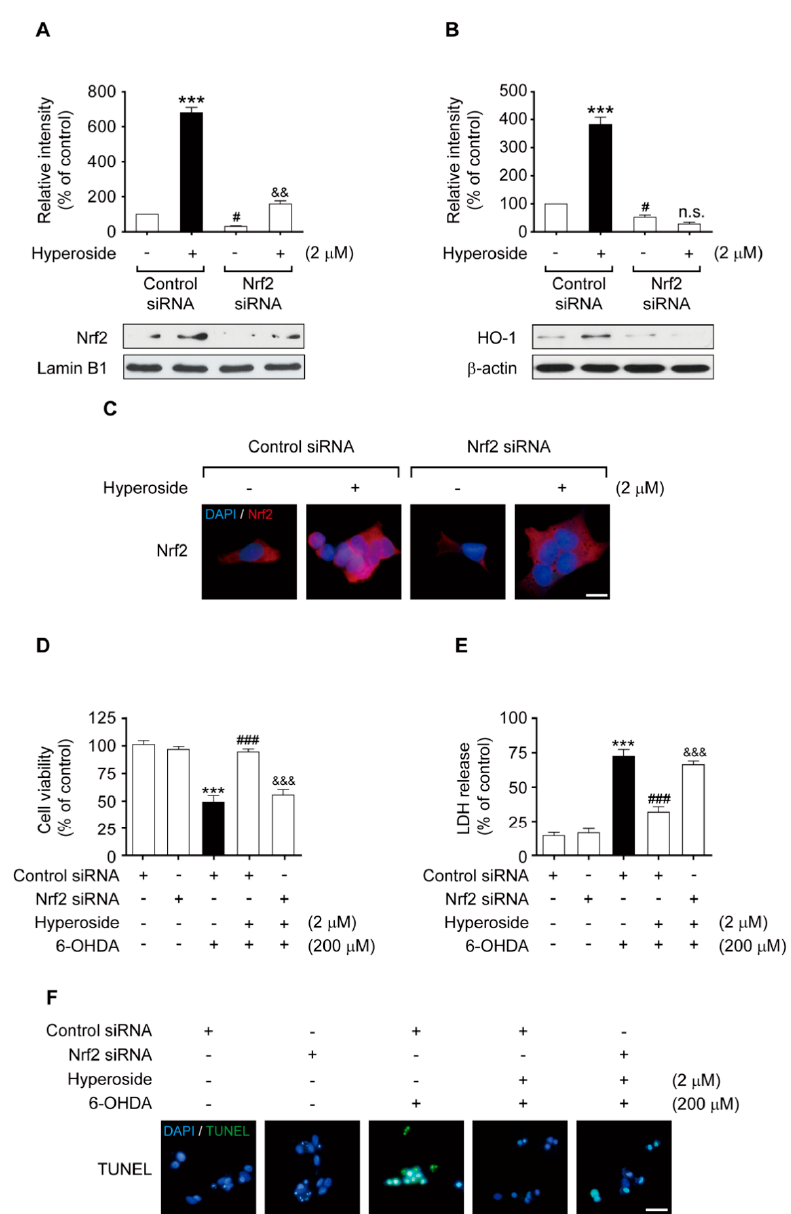
Figure 6. Nrf2 gene knockdown eliminated the neuroprotective effects of hyperoside on Nrf2-mediated HO-1 transcriptional induction. Cells were transiently transfected with an Nrf2 siRNA, as described in the Material and Methods, and then treated with or without 2 µ M hyperoside for 4 h prior to exposed to 200 µ M 6-OHDA for 24 h. Levels of Nrf2 ( A ), HO-1 ( B ), and β -actin were evaluated by Western blot analysis. Error bars indicate the mean ± SEM ( n = 3 ). *** p < 0.001 vs. the ( − ) control siRNA group. # p < 0.001 vs. ( + ) control siRNA group. && p < 0.01 vs. the ( + ) Nrf2 siRNA group. Knockdown of Nrf2 abolished the neuroprotective effects of hyperoside on cell death ( D ) and LDH release ( E ) induced by 6-OHDA. Cells were transiently transfected with the siRNA Nrf2 plasmid construct and then treated with 2 µ M hyperoside for 4 h, followed by exposure to 200 µ M 6-OHDA for 24 h. Cells were pretreated with the indicated concentrations of hyperoside for 4 h. Nrf2 was detected using an anti-Nrf2 antibody and a Texas red ® -conjugated secondary antibody ( C , 100 × magnification, scale bar: 50 µ m). DNA fragmentation was assayed using TUNEL fluorescent dye ( F ). Nuclei were stained with Hoechst 33258. Images shown are representative of three experiments and were visualized by fluorescence microscopy. Error bars indicate the mean ± SEM ( n = 6 ). *** p < 0.001 vs. the control group. ### p < 0.001 vs. the 6-OHDA-treated group. && p < 0.01 and &&& p < 0.001 vs. the 6-OHDA plus sieboldin-treated group. Scale bar: 100 µ